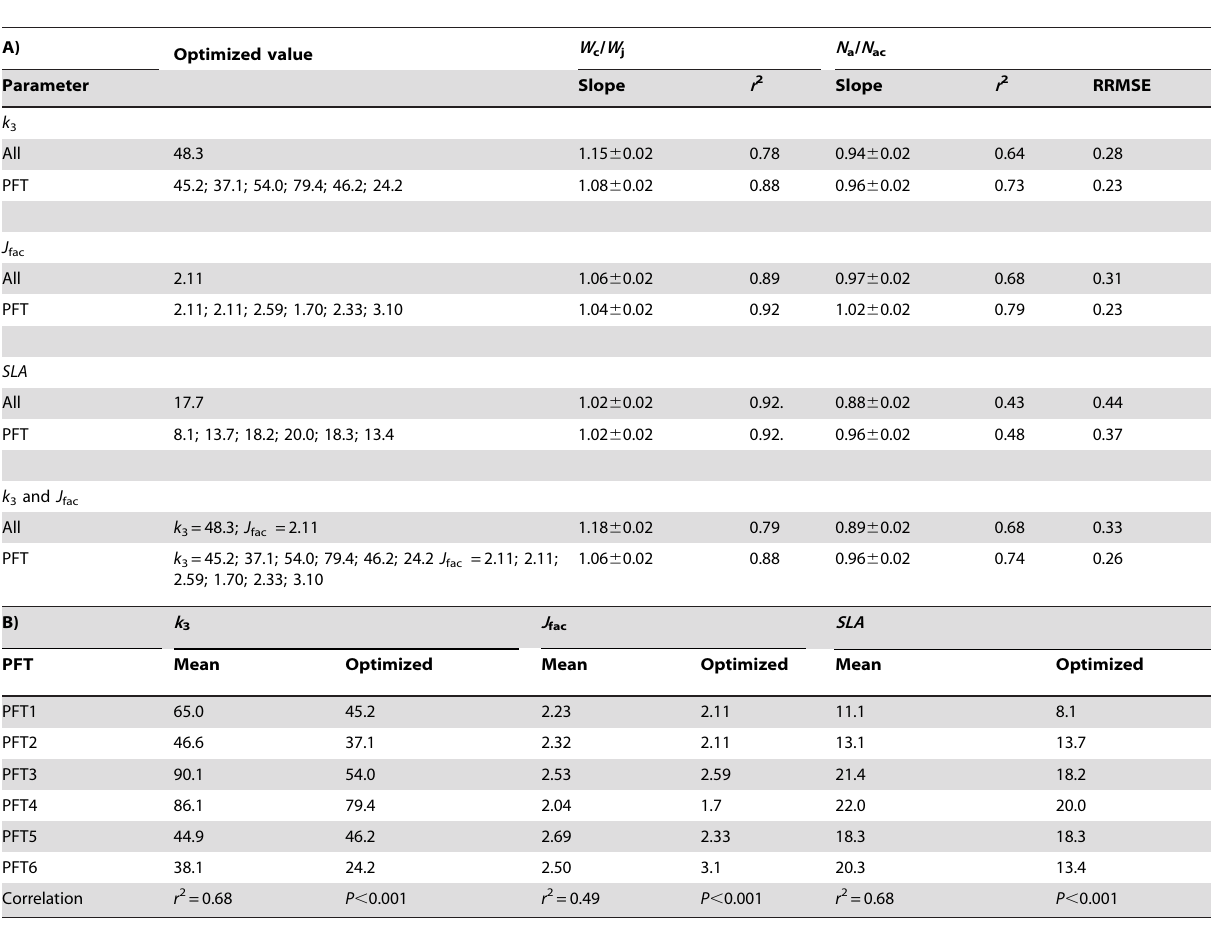
Table 3. Estimates of the optimized value (for the entire dataset and by PFT) of leaf photosynthetic traits ( J fac , k 3 and SLA